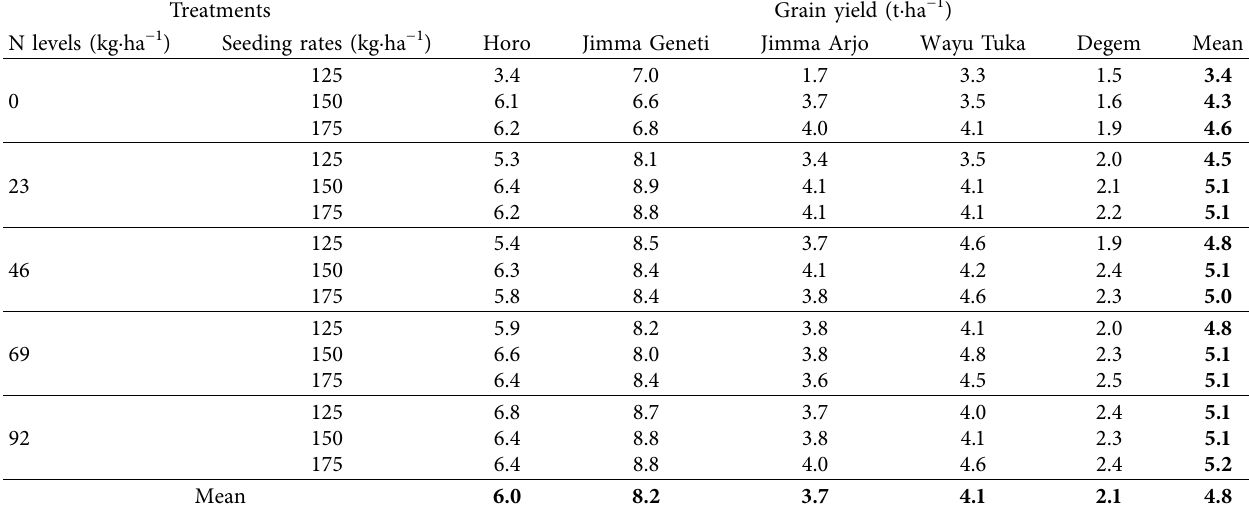
Bold values are the mean grain yield across the